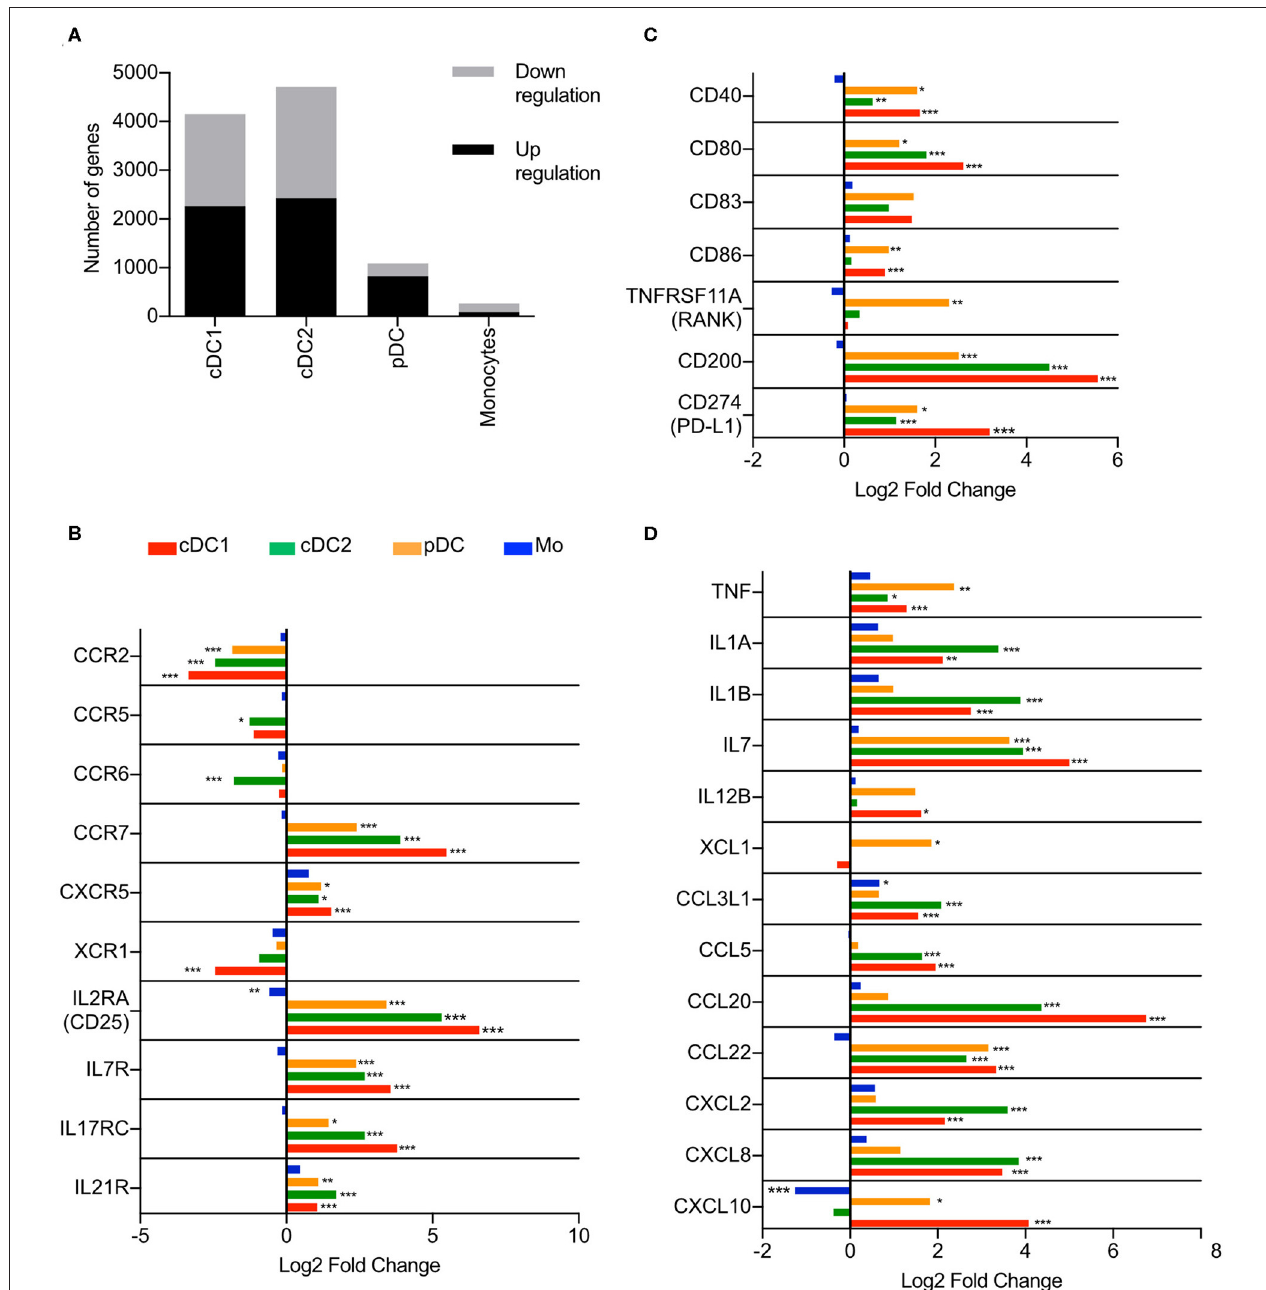
FIGURE 1 | Transcription profiles of porcine blood mononuclear phagocytes following PAM3Cys stimulation. cDC1, cDC2, pDC and monocytes from three different animals were sorted by FACS and stimulated for 3h with 10 µ g/ml of PAM3Cys or left unstimulated as control. (A) Number of significantly regulated genes (padj < 0.05) when comparing PAM3Cys-stimulated cells to the corresponding non-stimulated control. (B) Expression of selected chemokine and cytokine receptor genes as log2 fold change between PAM3Cys-stimulated cells and their corresponding non-stimulated control. (C) Expression of selected costimulatory molecule genes as log2 fold change between PAM3Cys-stimulated cells and their corresponding non-stimulated control. (D) Expression of selected chemokine and cytokine genes as log2 fold change between PAM3Cys-stimulated cells and their corresponding non-stimulated control. DESeq2 analysis * padj < 0.05, ** padj < 0.01, *** padj < 0.0001.